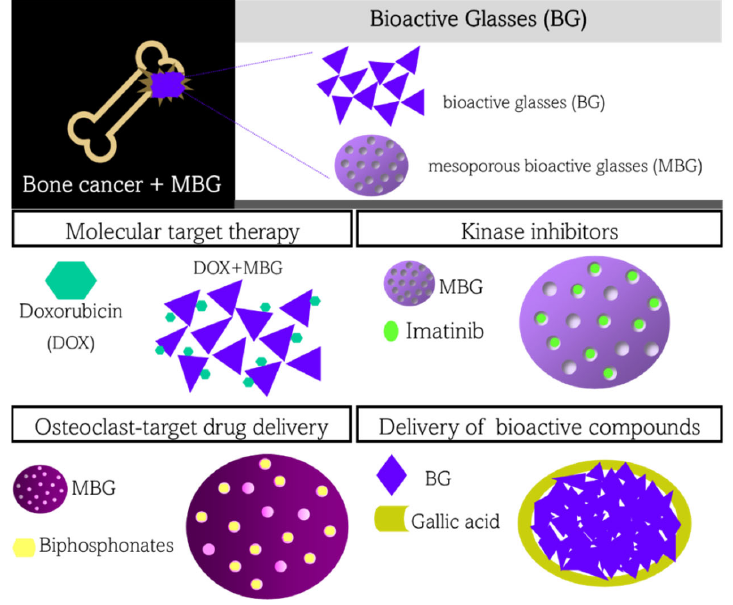
Figure 2. Application of bioactive glasses as drug carriers of drugs used in bone cancer treatment.